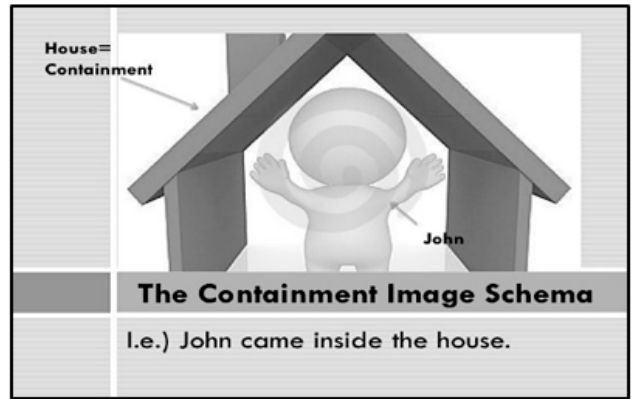
Figure 1. The containment Image Figure 1. The CONTAINMENT Image Schema.